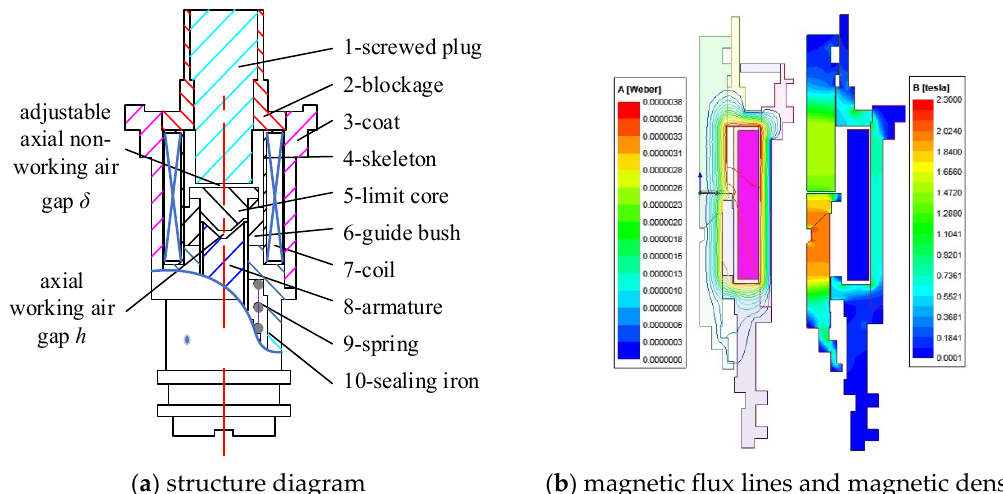
Figure 1. Structure diagram and magnetic field distribution of the HFSV.